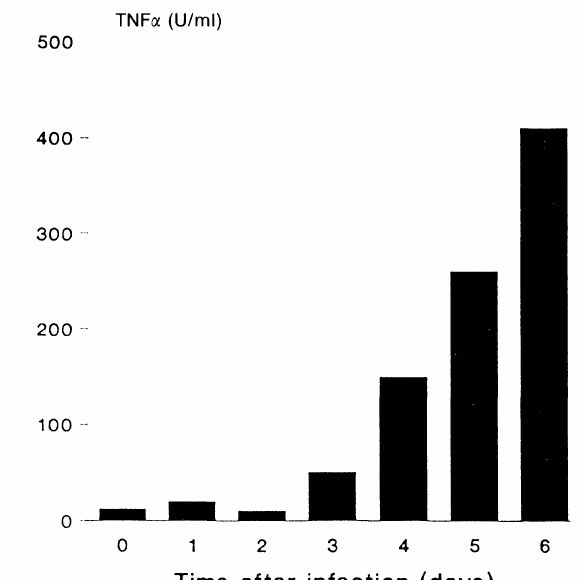
FIG. 1. Enhanced production of TNF by LPS in C3H/HeN mice infected with S. Typhimurium. Mice were infected with 50 CFU S. typhimurium and challenged with 10 #g LPS. Plasma was collected 60 min after LPS administration.